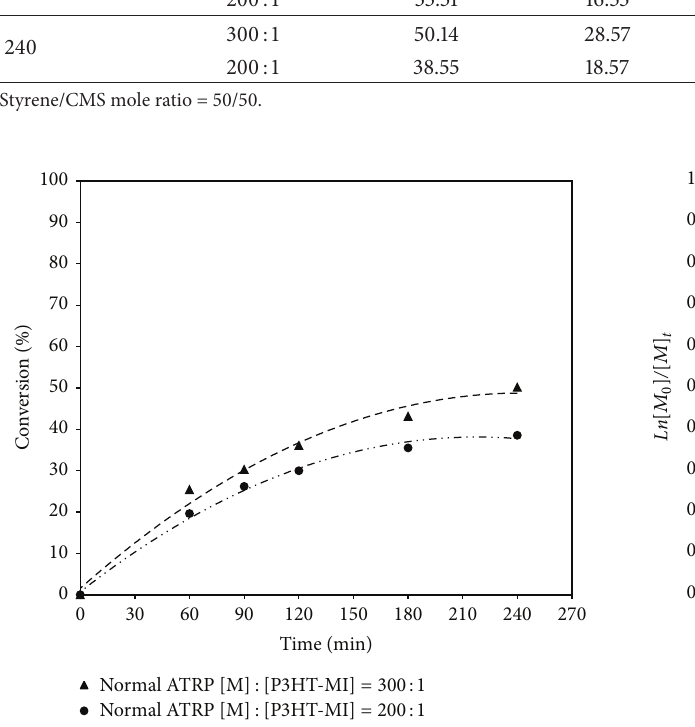
Figure 7: Relationships between monomer conversion and reaction time during ATRP of styrene and CMS at 100 ∘ C.